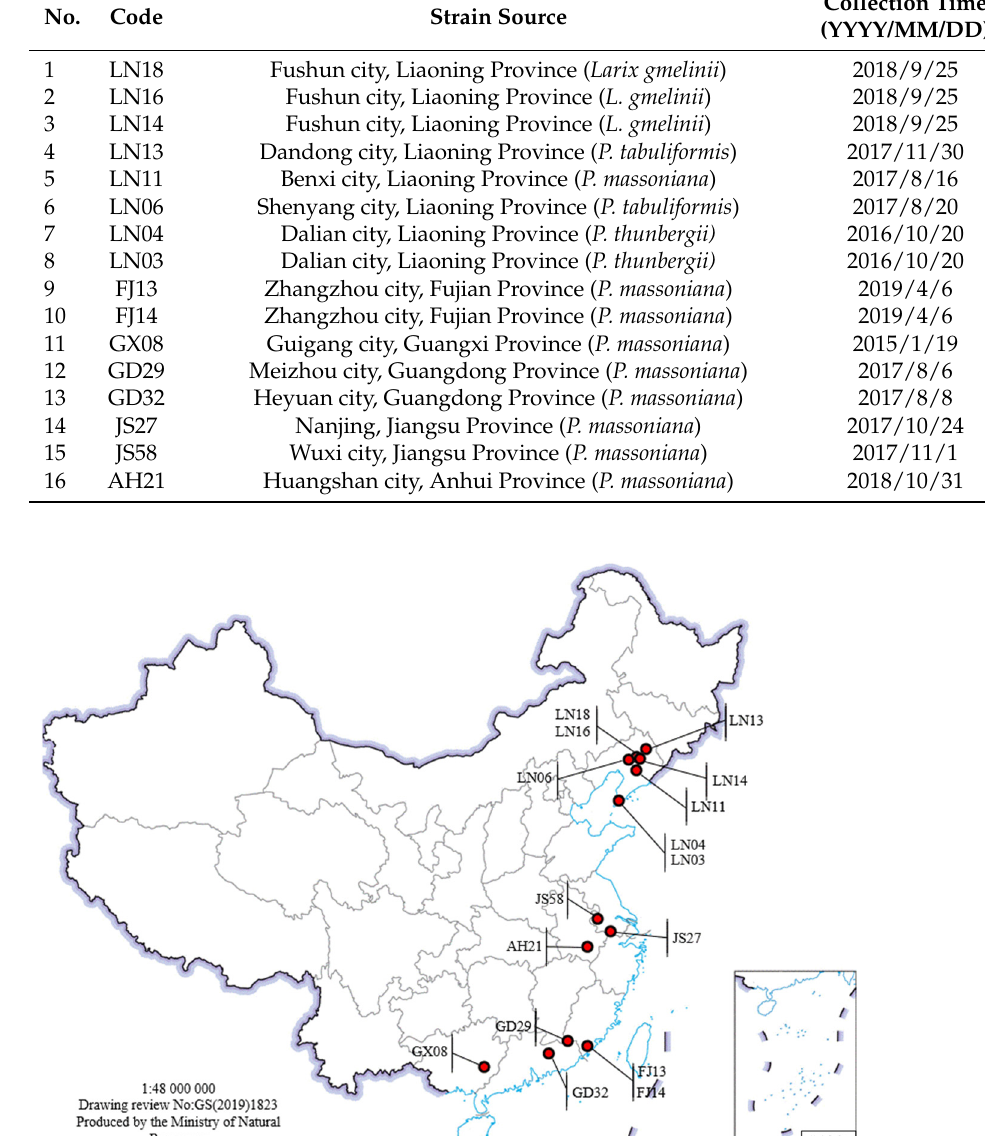
Table 2. Sources and codes of the pine wood nematode (PWN) isolates used in the study. No.